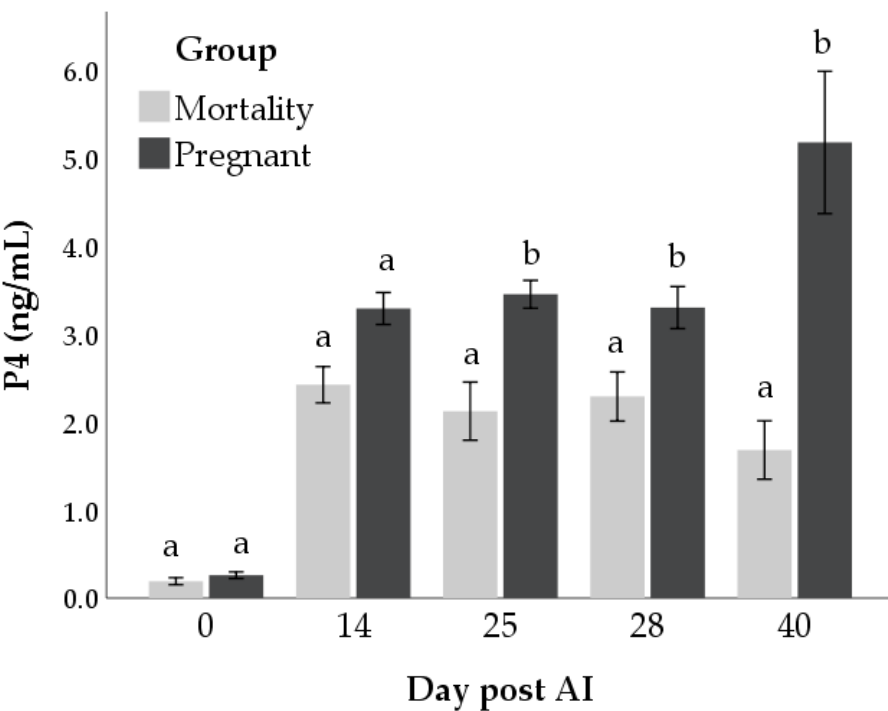
Figure 1. Concentrations of progesterone (P4) in mortality and pregnant groups at day 0, 14, 25, 28 and 40 post-AI. Bars not sharing the same superscript within each day are significantly different at p < 0.05.